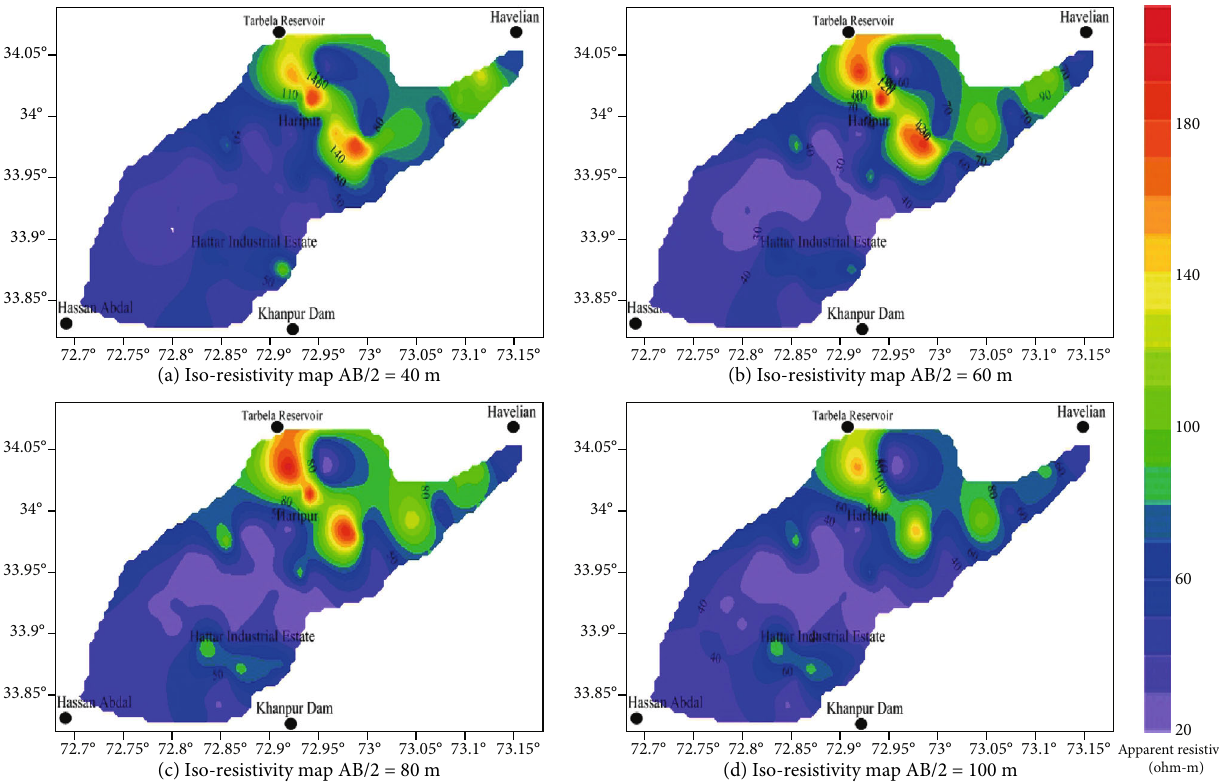
Figure 9: Spatial distribution resistivity maps generated at (a) 40m, (b) 60 m, (c) 80 m, and (d) 100 m depths. The maps represent distribution of resistivity at certain depths. The high resistivity values are encountered in the north that may suggest presence of saturated/unsaturated fi ne lithologies. In the center and southwest, lowest resistivity values are present that suggests relatively coarser lithologies such as gravel, boulders, and